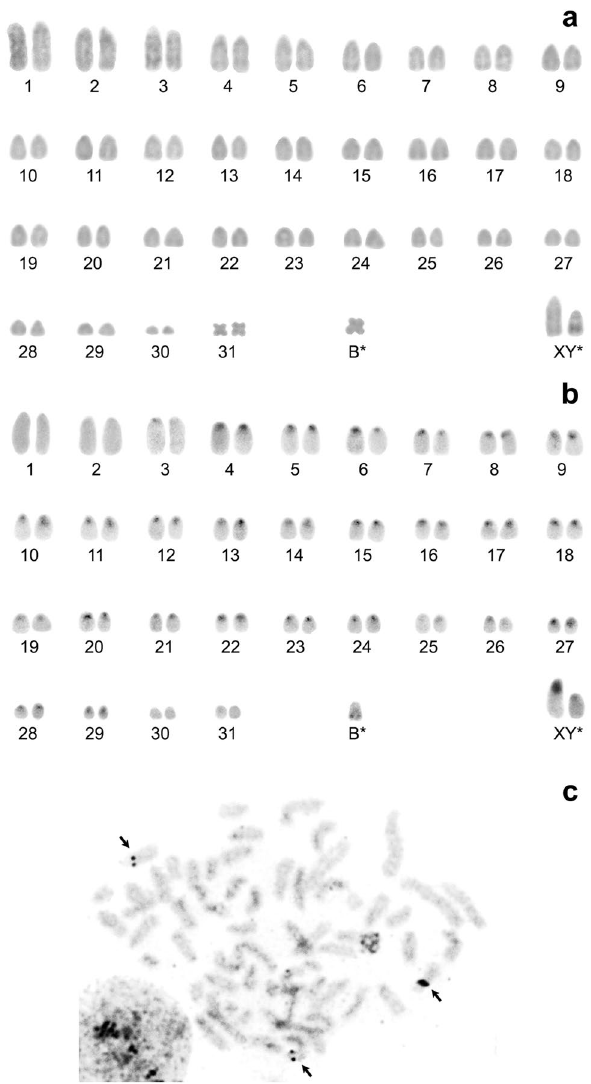
Figure 5. A male karyotype of Chodsigoa hypsibia from Gansu Province (Zhuoni County). ( a ) Conventional staining; ( b ) C-banding; 2n = 65, NF a = 66 (including a B chromosome); ( c ) silver staining. Black arrows indicate the locations of NORs. Asterisks indicate possible chromosome variants (see the main text for details). XY: sex